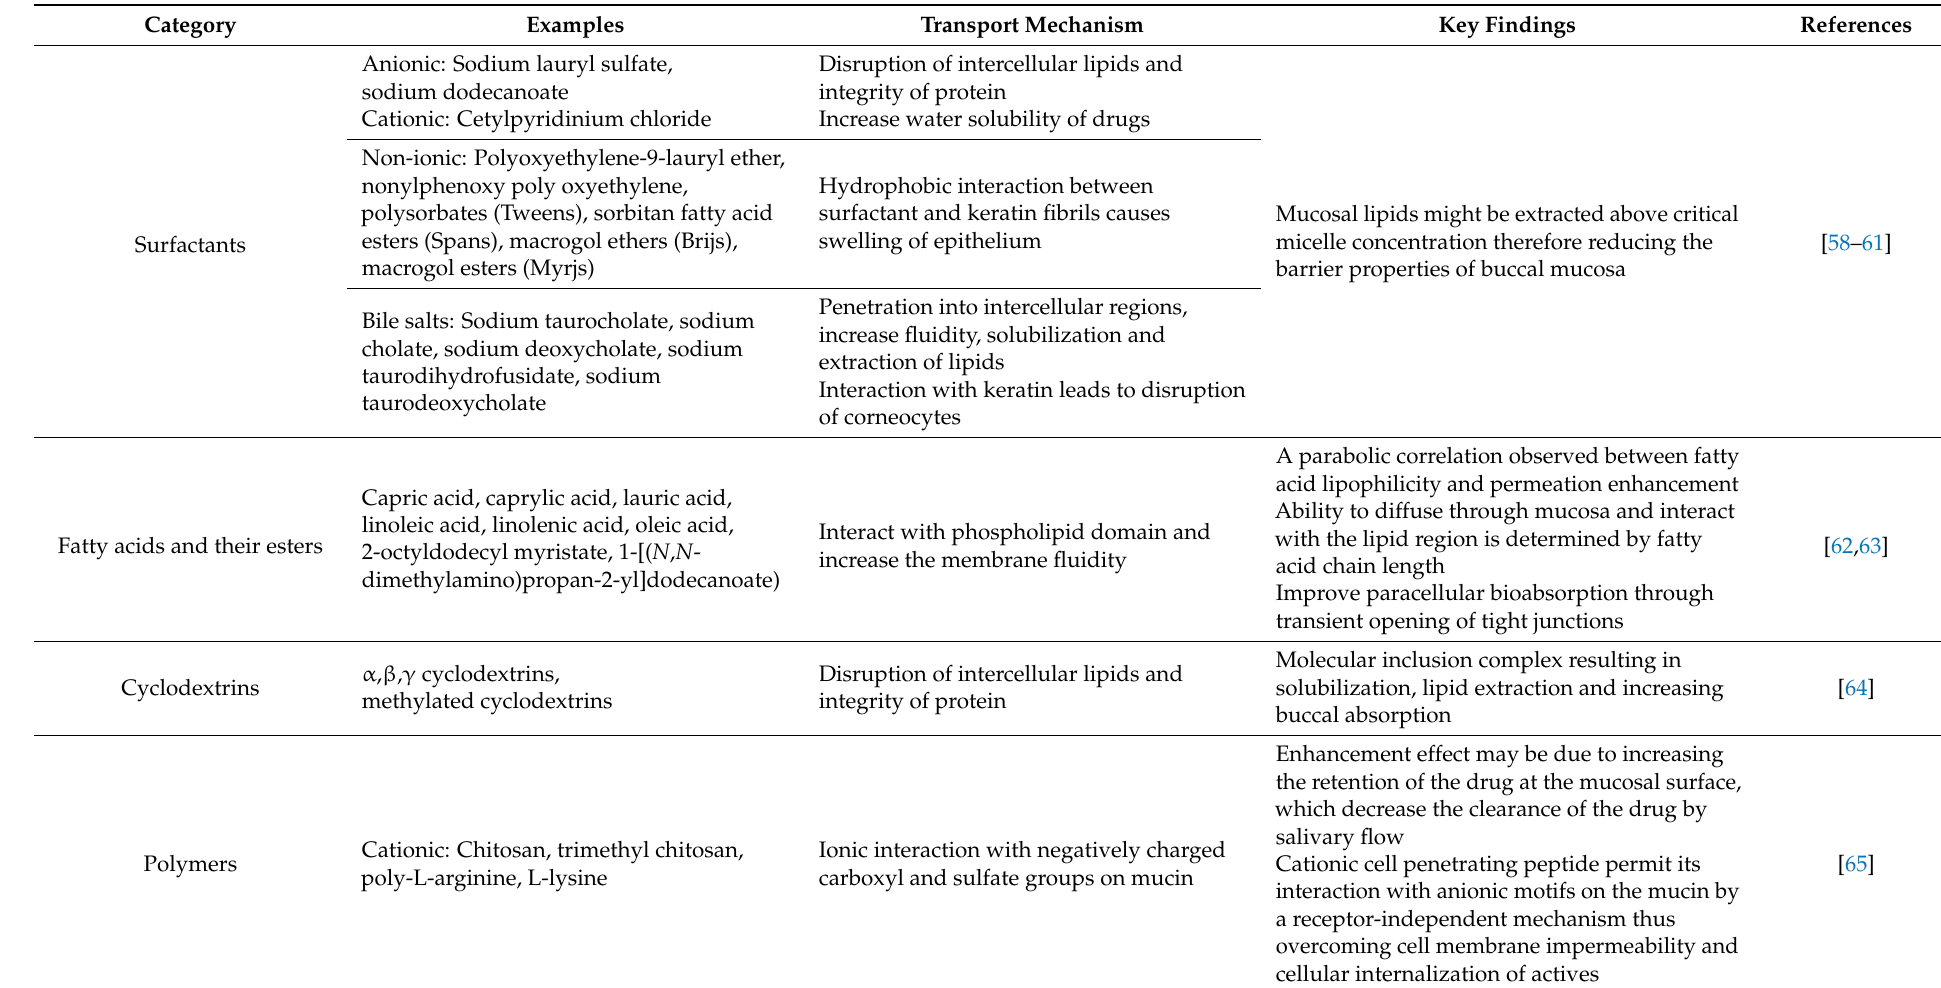
Table 1. List of penetration enhancers, transport mechanisms, and key